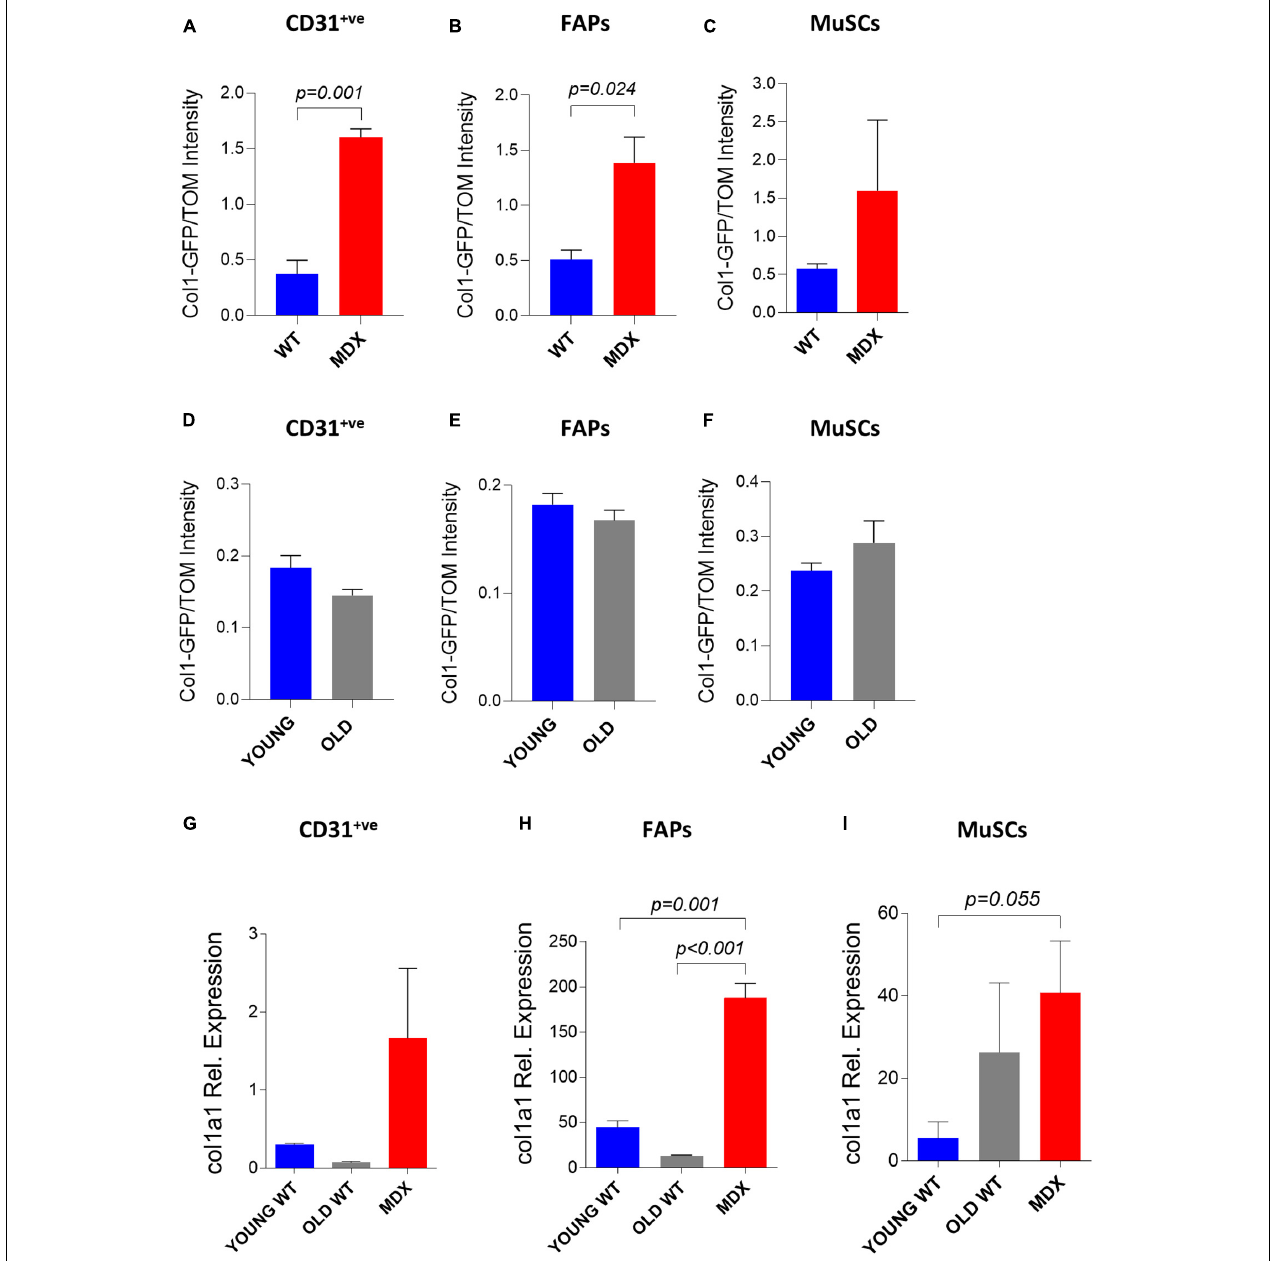
FIGURE 6 | Study of collagen 1 expression in muscle single cells through in vivo electroporation. (A–C) Col1-GFP/TOM Intensity (median) in CD31 + ve (A) , FAPs (B) and MuSCs (C) from TA of ∼ 12 months-old C57BL/6J (WT) and mdx 4Cv (MDX) mice injected with Col1-GFP:tdTomato (Col1-GFP/TOM) mix (10:1) and electroporated. The analysis was performed 2 weeks after electroporation. N = 3 for all samples except MuSCs MDX ( N = 2). (D–F) Col1-GFP/TOM Intensity (median) in CD31 + ve (D) , FAPs (E) and MuSCs (F) from TA of ∼ 2 months-old (YOUNG) and ∼ 24–26 months-old (OLD) C57BL/6J mice injected with Col1-GFP/TOM mix (10:1) and electroporated. The analysis was performed 2 weeks after electroporation. N = 3. (G–I) qPCR analysis of collagen1a1 in CD31 + ve (G) , FAPs (H) and MuSCs (I) from ∼ 2 months-old C57BL/6J (YOUNG WT), ∼ 24 months-old (OLD WT) and ∼ 12 months-old mdx 4Cv (MDX) hindlimb muscles. FAPs: CD45 – ve CD31 – ve sca1 + ve cells; MuSCs: CD45 – ve CD31 – ve sca1 – ve vcam + ve